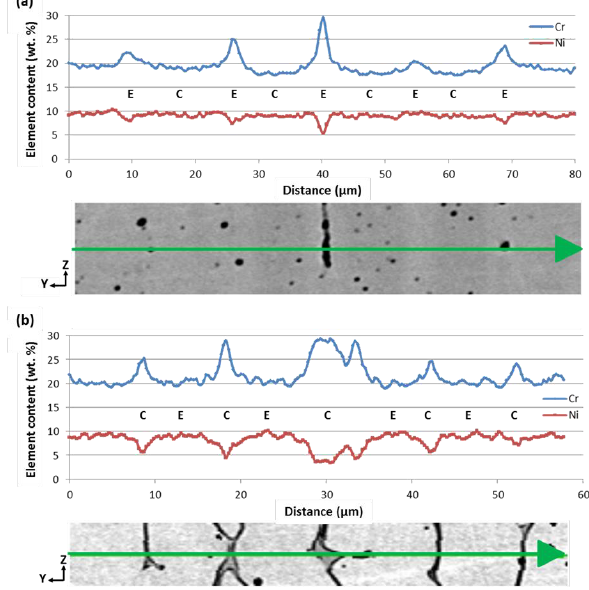
Figure 5. Cr and Ni profiles measured by EDS. ( a ) Across several austenitic cells (AF region in Figure 4); ( b ) Across several secondary arms of two-phase dendrites (FA region in Figure 4). C and E refer respectively to centers and edges of cells or dendrites. Extrema of Cr and Ni contents are measured in ferrite and depend on the size of the probed volume relative to that of the ferrite phase, thus they cannot be considered as